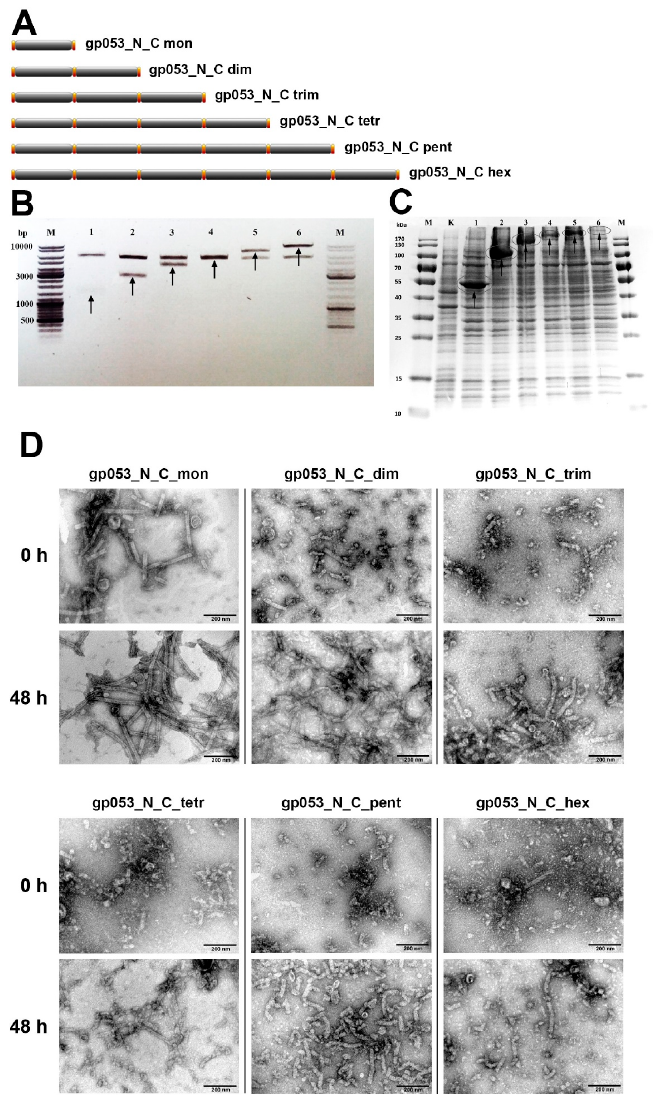
Figure 8. Assembling of the gp053 oligomers. ( A ) A schematic representation of the gp053 oligomeric constructs. The amino acids of the wild-type gp053 within the construct are shown in black, and the insertions with cloning sites are shown in orange. The constructs are named according to the number of copies of the gene 053 . ( B ) The agarose gel electrophoresis analysis of plasmids harbouring the fused 053 genes. The arrows indicate DNA fragments encoding gp053 after hydrolysis with NdeI and XhoI. Lanes: M—molecular mass marker, GeneRuler™ DNA Ladder Mix